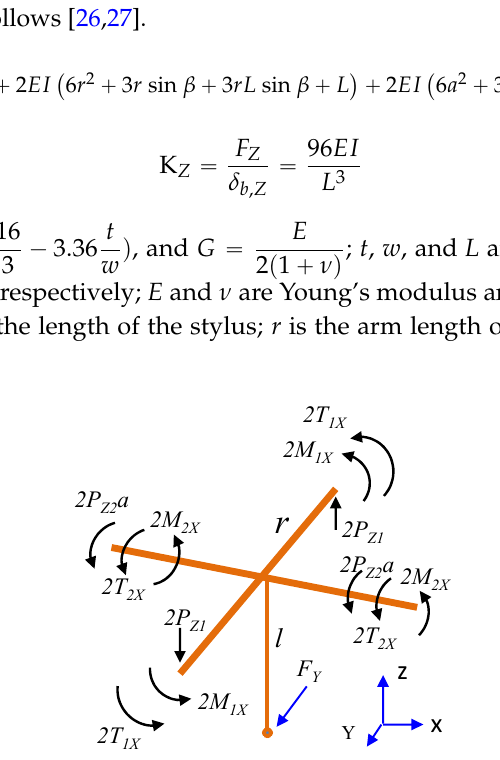
Figure 5. Free ‐ body diagram of the floating plate. Figure 5. Free-body diagram of the floating plate.